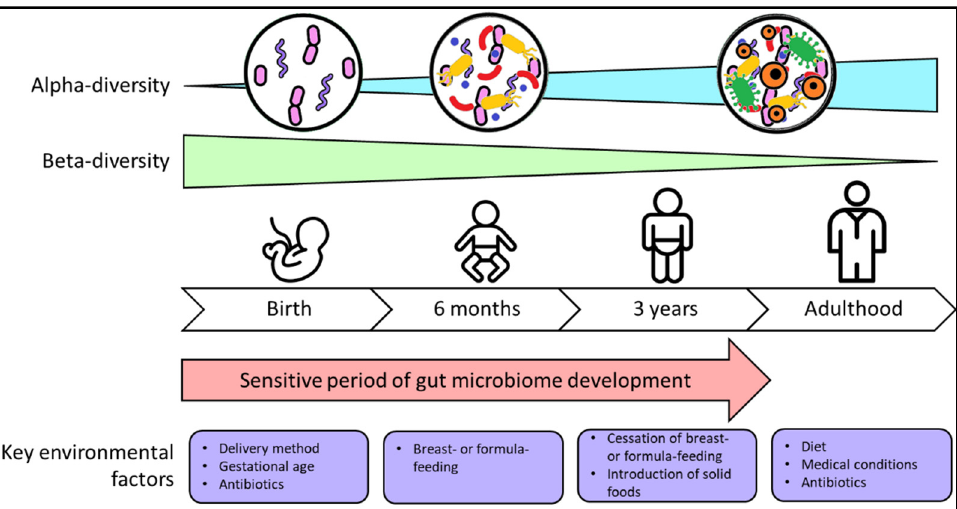
Figure 1. The developing gut microbiome and major influencing environmental factors. Alpha-diversity (diversity within one sample) increases as the gut microbiome develops. The beta-diversity (diversity between samples) decreases with age, indicating that gut microbiome differences are most variable between people during infancy, and become more similar n adulthood. The first three years of life represent a period of heightened plasticity where gut microbiome development is easily impacted by environmental factors.